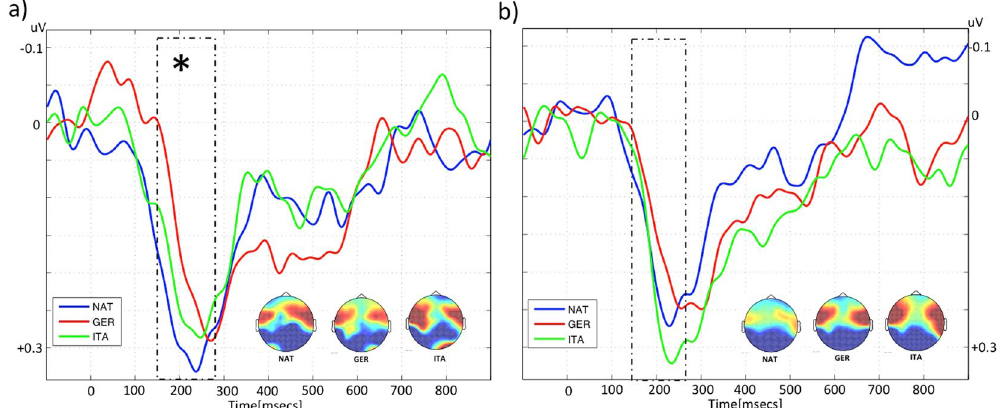
Figure 1. Grand-averaged event related potential waveforms of Monolingual (left) and Bilingual (right) infants to Native (blue), Italian (green) and German (red) languages. Amplitude in mv is plotted in the y axis and time in msecs is plotted in the x axis. Zero corresponds to the beggining of the utterances. ERP responses are averages over the ROI. Each arrow indicates the first substantial positive peak in the waveform which often occurs between about 150 and 275 ms. In our data, P200 component was presented between 150–280 ms (dashed box) and showed a high activation on the frontocentral area (topoplot